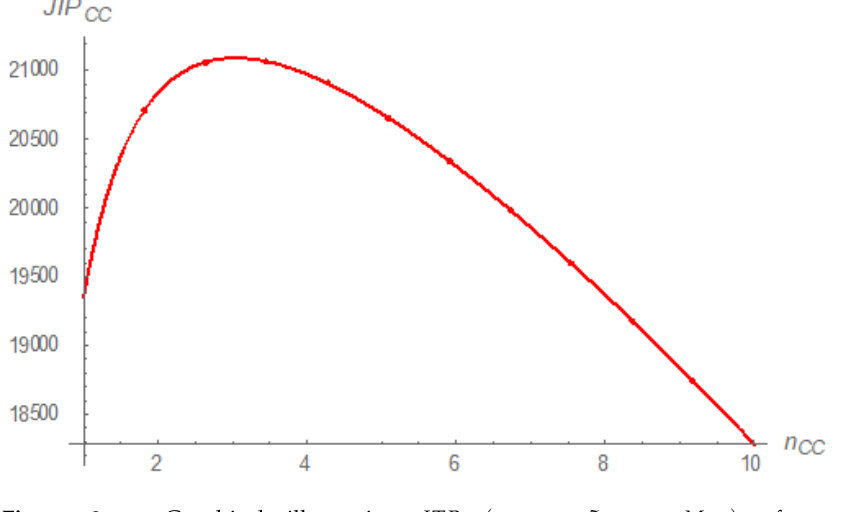
for n for CC CC